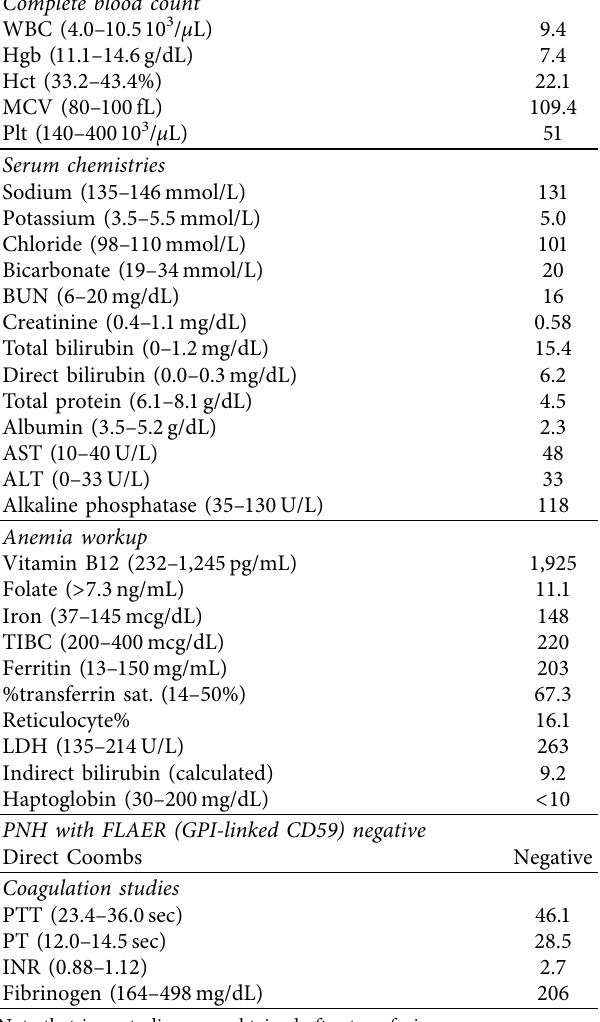
Table 1: Laboratory data from